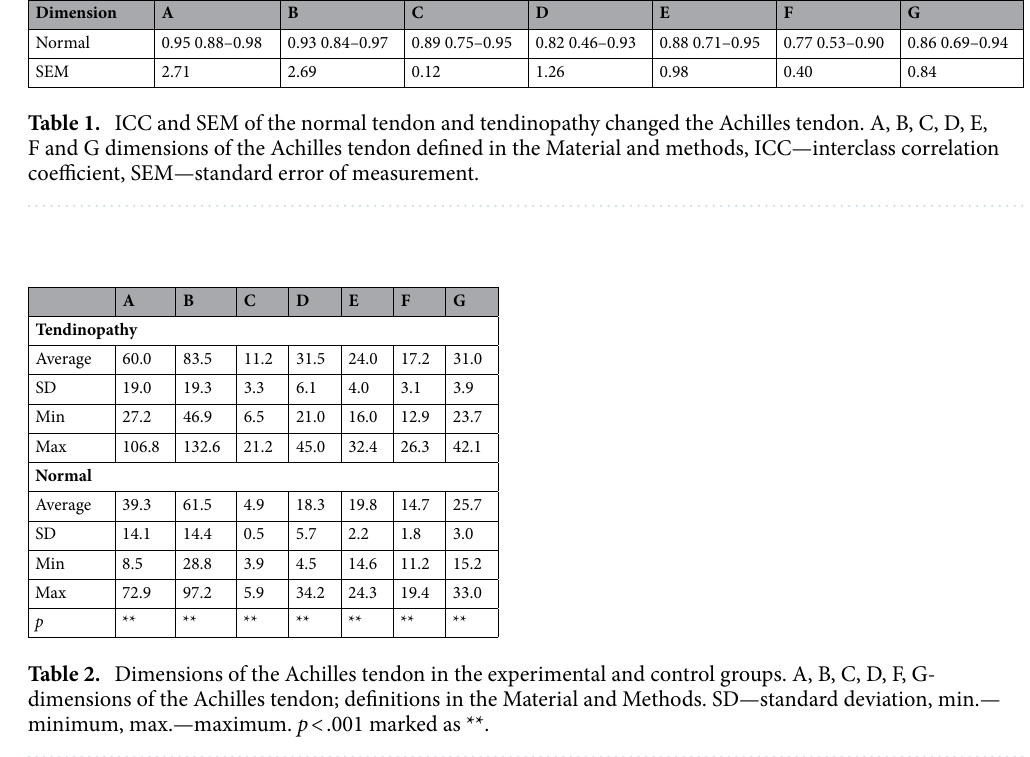
Fig. 1. The width of the midportion (distance F) was assessed at the same level as the distance C on the axial section. The Achilles tendons insertion width (distance G) was assessed in the middle of the D dimension on the axial section, Fig. 1.